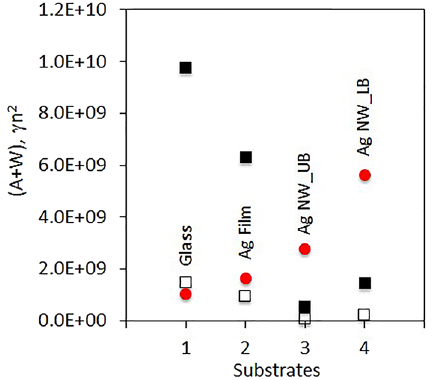
Figure 7: Decay rates A + W (red circles) and γ n 2 , calculated at n = 9.5 g/l (open squares) and n = 24.6 g/l (solid squares) on top of theglass (1,glass),ontop of Ag fi lm(2,Ag fi lm),andontopof arrays of Agnanowires,closeto theupperboundary(3, AgNW_UB)andthe lower boundary (4, Ag NW_LB) of the kinetics